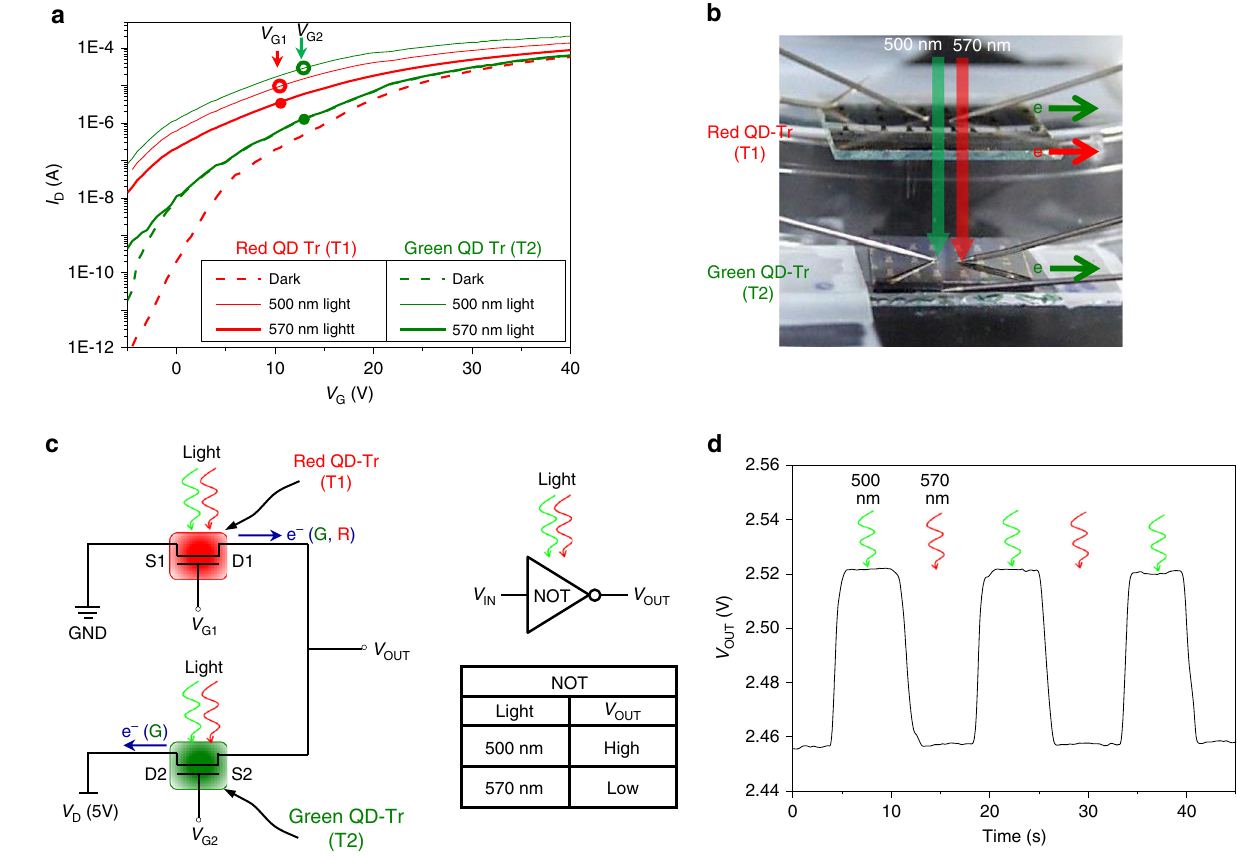
Fig. 5 Logic inverter using red- and green-quantum dot phototransistors. a Photoresponses of 1RQ- and 1GQ-OQO phototransistors with respect to incident light wavelengths. Both transistors exhibit photoresponses at 500-nm wavelength illumination. For 570-nm-wavelength irradiation, the photoresponse is only observed for the 1RQ-OQO devices. b Stacked con fi guration of 1RQ- and 1GQ-OQO phototransistors prepared on transparent glass substrates for logic inverters. c Electro-optical NOT gate circuitry and resultant logic table. d Time-domain measurement of V out at alternated 500- and 570-nm illumination